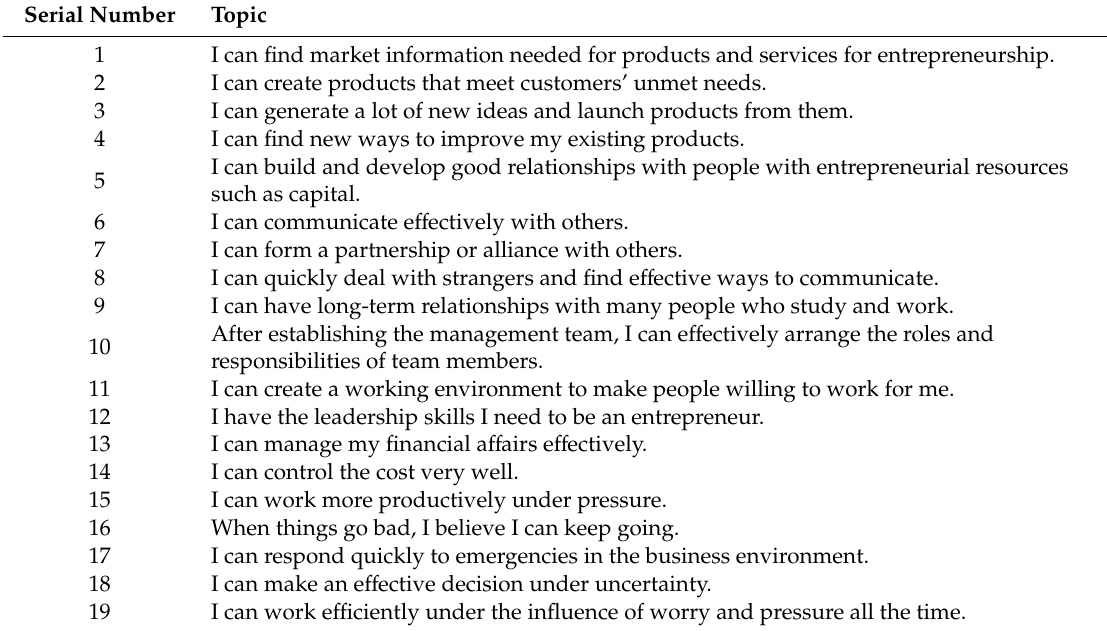
Table A1. Entrepreneurial Self-E ffi cacy